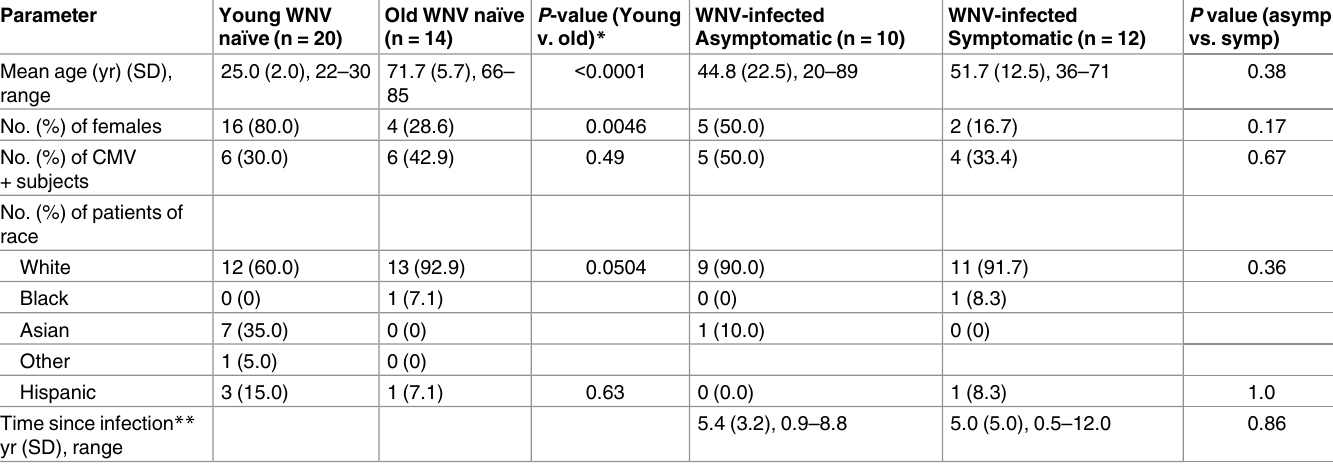
Table 1. Cohort demographics.